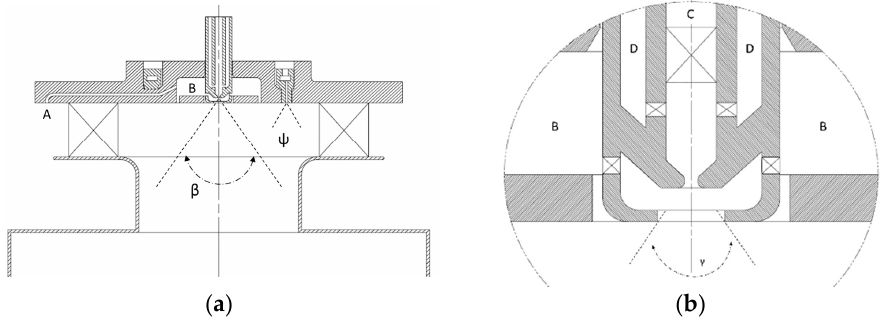
Figure 3. ( a ): Schematic cross-sectional view of dual-fuel combustor, central pilot and one out of four main nozzles are in the cutting layer; β denotes the total characteristic spray angle of the pilot fuel and ψ denotes the total characteristic spray angle of the pilot fuel. ( b ) Detailed view of central pilot nozzle; symbols ‘A’ denote pre-swirler plenum, ‘B’ plate cooling air plenum, ‘C’ primary 2 liquid line, ‘D’ primary 1 liquid line, and γ denotes the swirling angle of the cap cooling air, re- spectively.